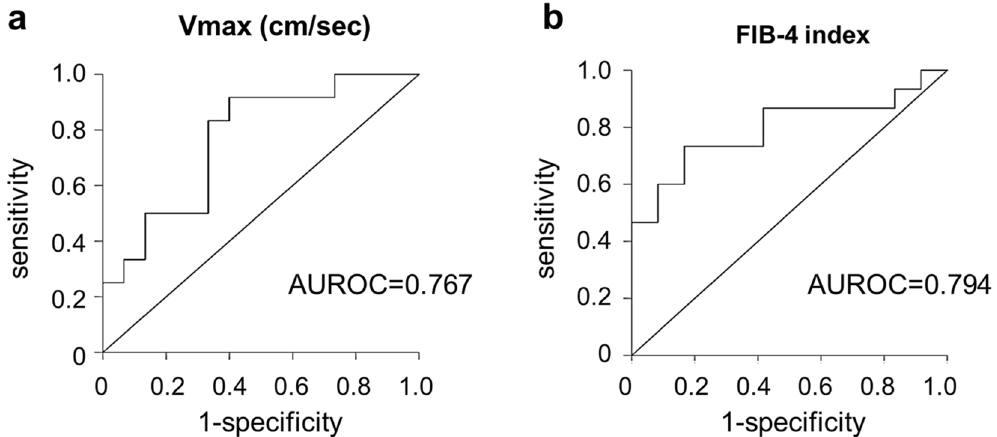
Figure 5. Area under the receiver-operating characteristic curves (AUROC) of ( a ) velocity of right portal vein and ( b ) Fibrosis (FIB)-4 index for predicting liver stiffness measured by TE with Fibroscan (> 5